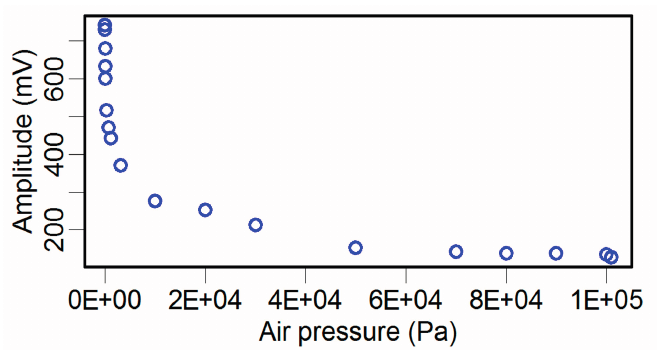
Figure 7. Atmosphere pressure vs. the oscillation amplitude of the